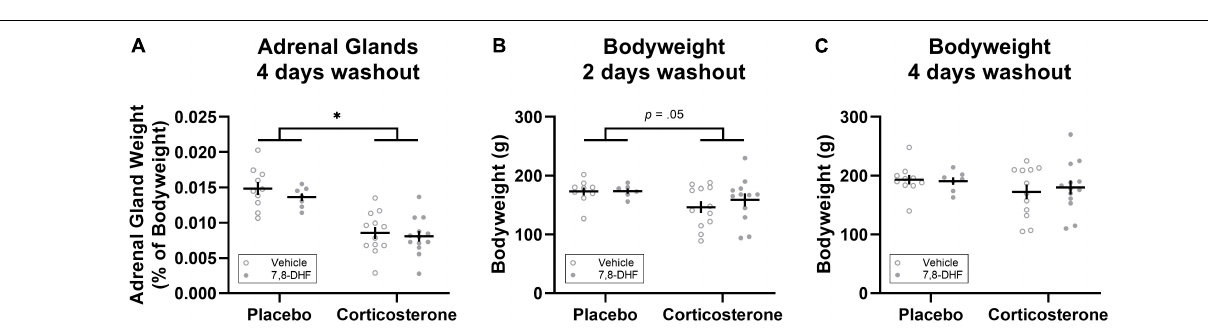
FIGURE 3 | Corticosterone pellet exposure reduced adrenal gland weight as a percentage of bodyweight (A) and bodyweight 2 days after treatment cessation (B) but did not affect bodyweight 4 days after treatment cessation (C) relative to placebo treatment. Data is shown as individual dot plots with mean ( ± SEM). Asterisk represents significant ( p < 0.001) group difference. Group sizes were n = 17 for the placebo (vehicle n = 10, 7,8-DHF n = 7) and n = 25 for the corticosterone (vehicle n = 12, 7,8-DHF n = 13) group at 4 days washout, and n = 15 for the placebo (vehicle n = 9, 7,8-DHF n = 6) and n = 24 for the corticosterone (vehicle n = 12, 7,8-DHF n = 12) group at 2 days